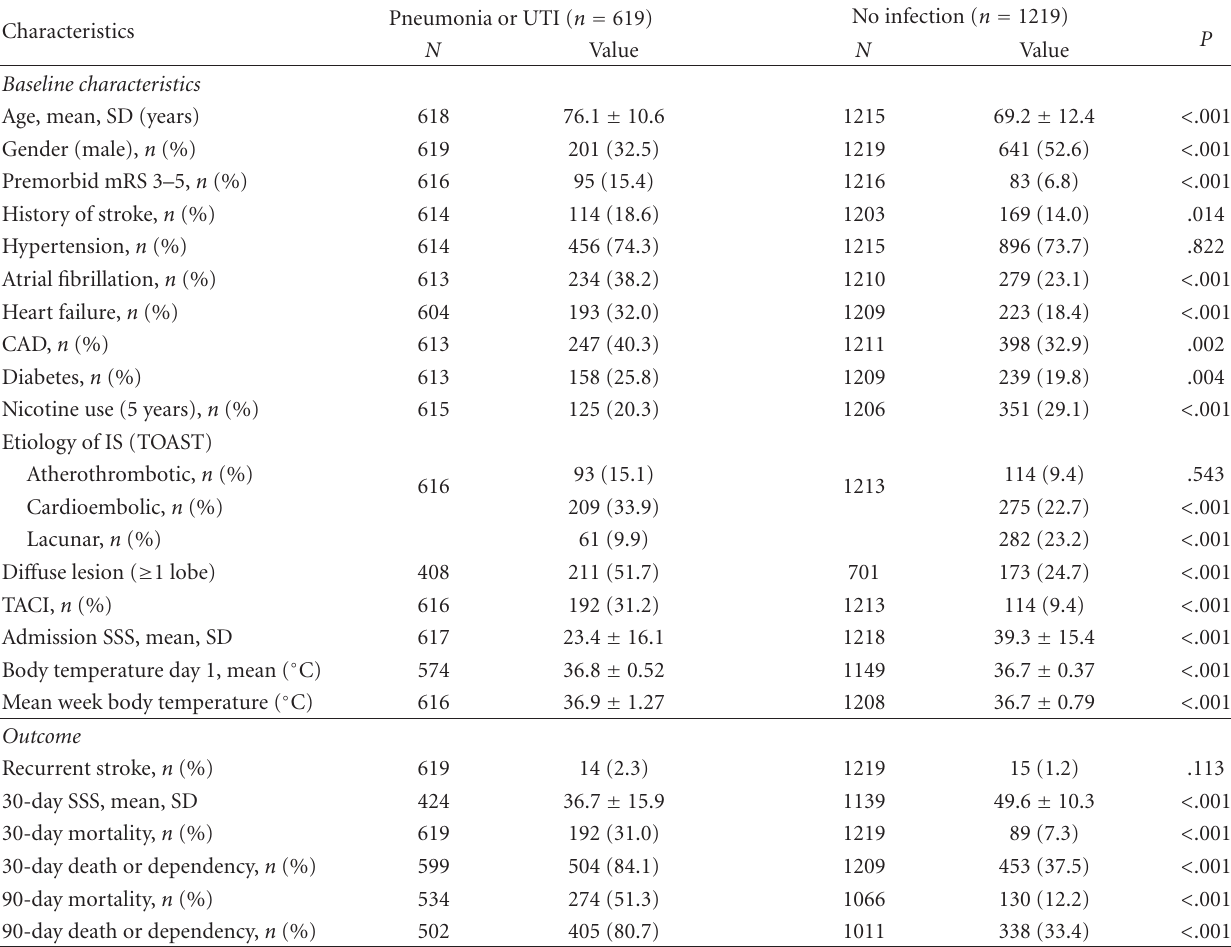
Table 2: Characteristics of patients with or without an in-hospital